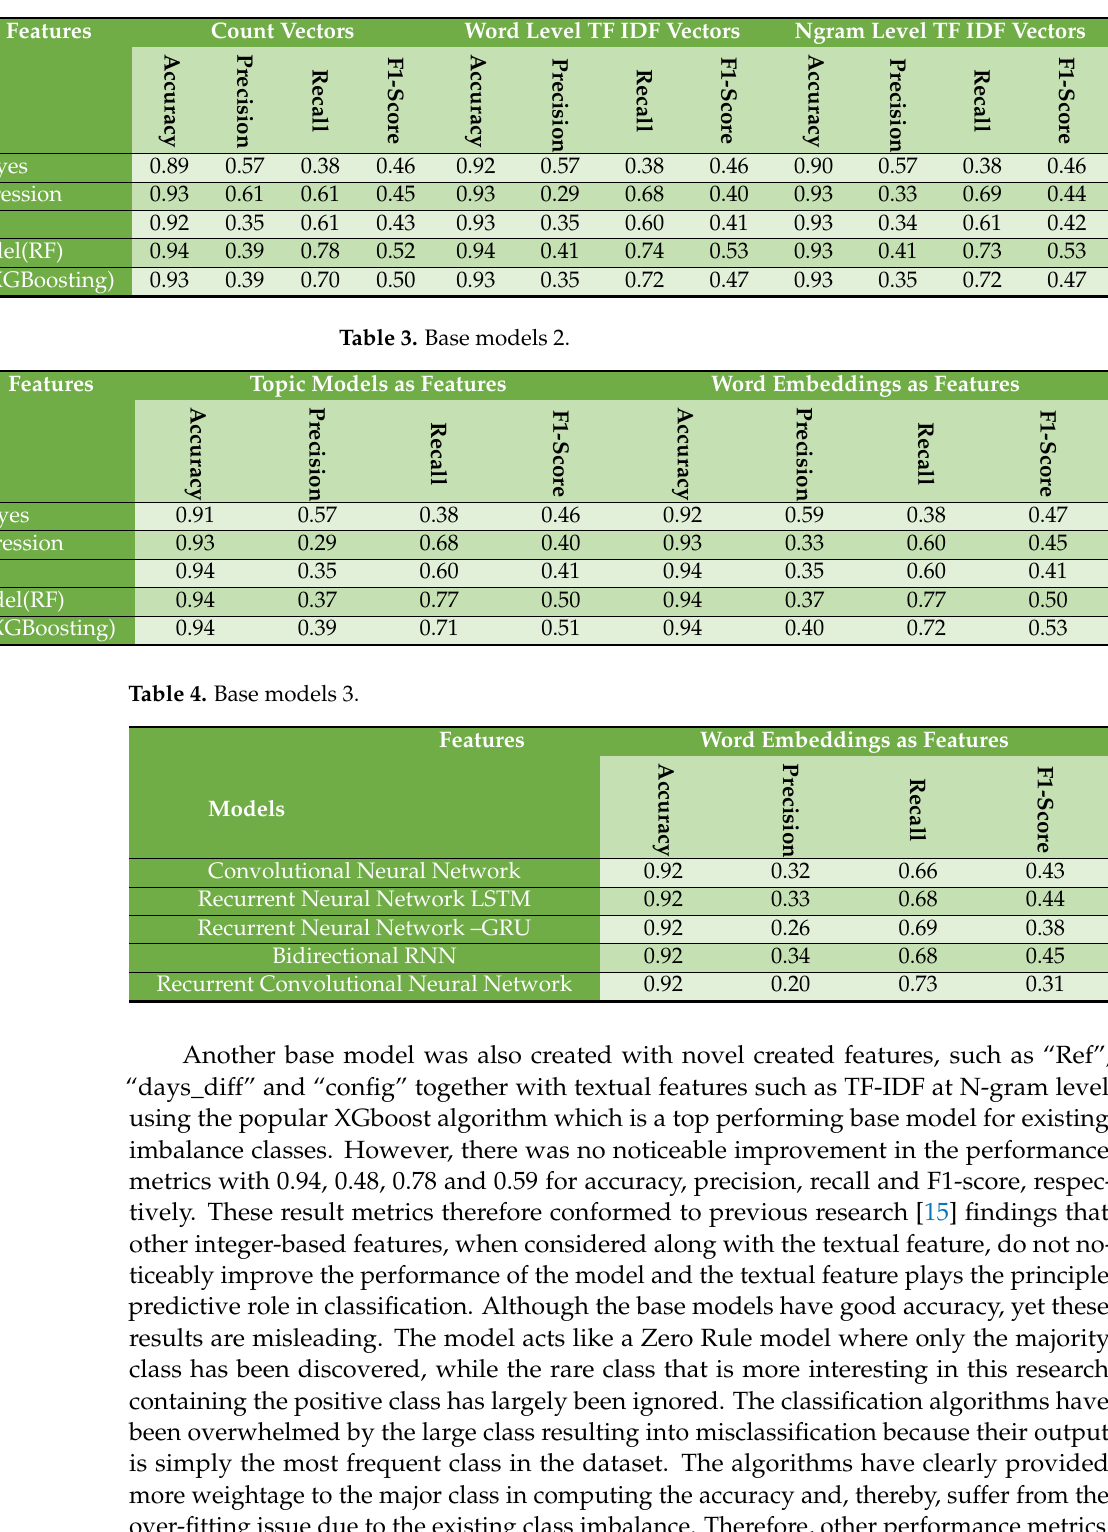
Table 2. Base models 1.